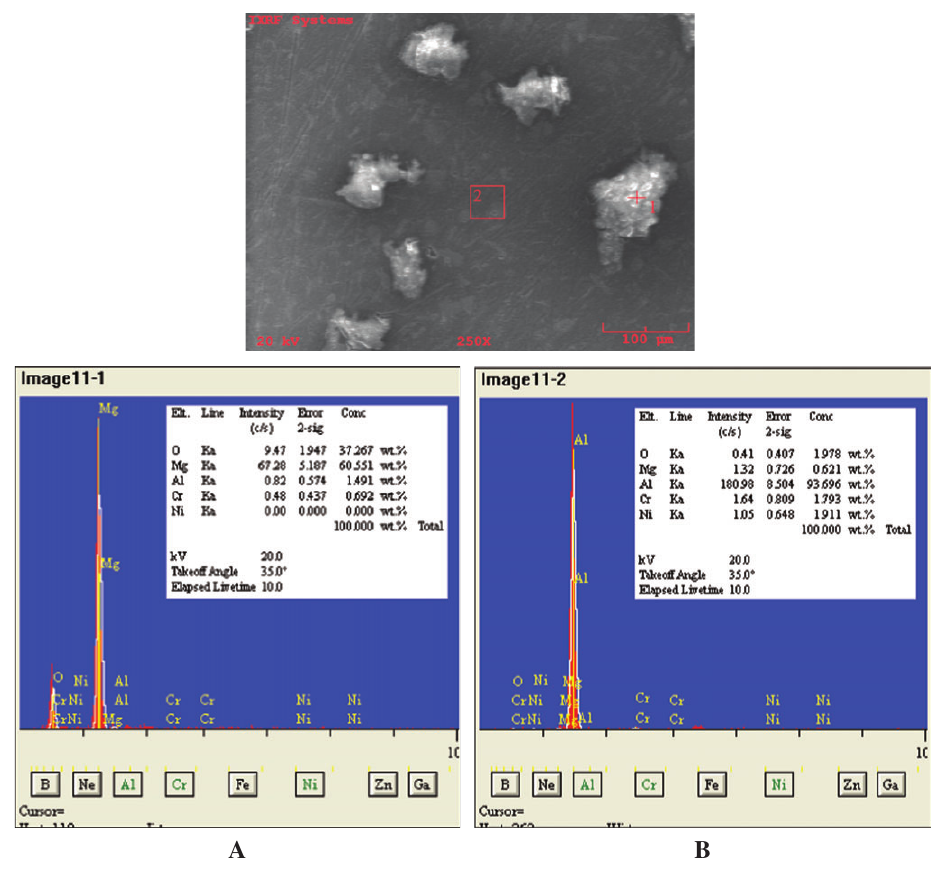
Figure 4 EDS analysis results of the composite taken from two different zones. (A) Analysis of Zone 1, (B) analysis of Zone 2 (JEOL JSM-6060 LV, Scanning Electron Microscope, Japan).